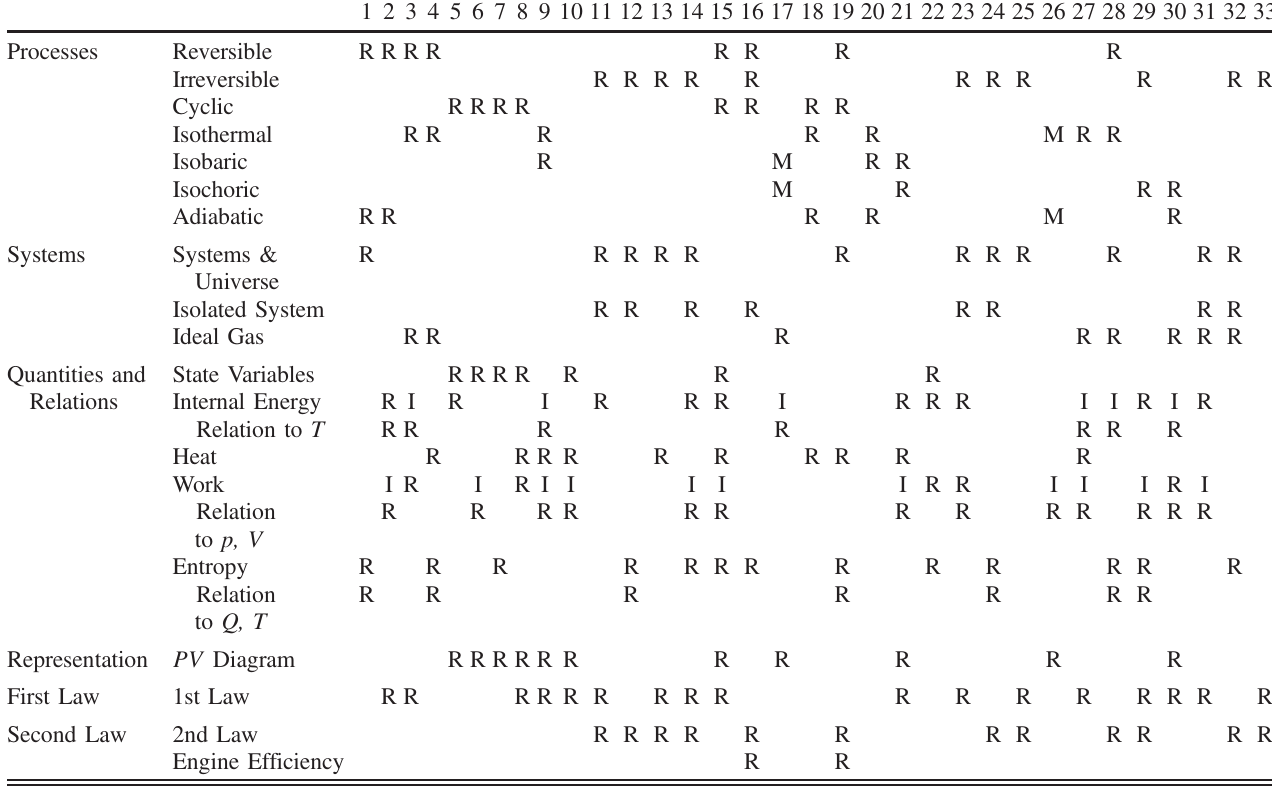
TABLE I. Topics by item number. Pitt physics faculty members and the Pitt physics education research (PER) group independently reached a consensus on identifying topics involved in each problem. An “ M ” indicates that a concept was mentioned but not required to solve the problem in the opinion of content experts. An “ R ” indicates that a concept is required to solve the problem. An “ I ” indicates that a topic is implicitly required though not explicitly asked for or mentioned. For instance, generally, if a student must reason about a PV diagram to infer the heat transfer to a system, the concept of “ work ” is implicitly